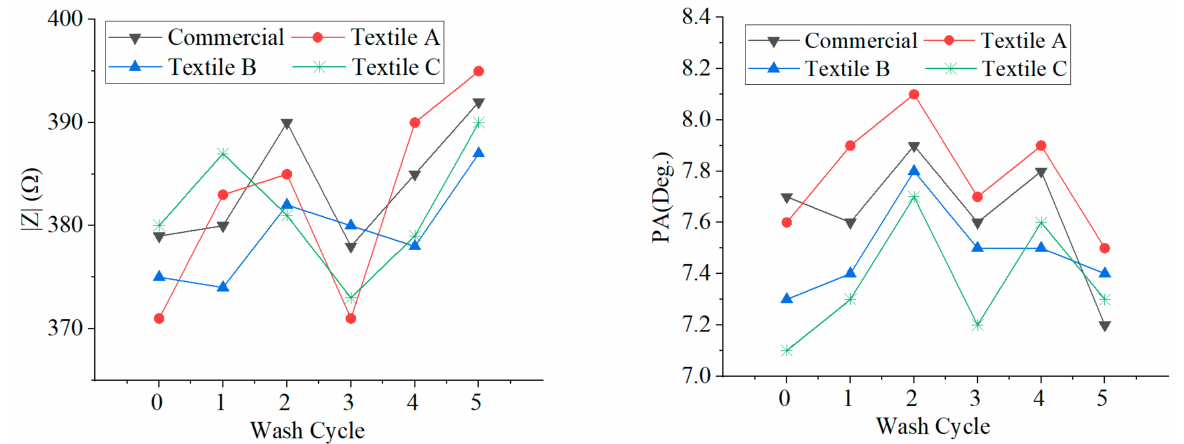
Figure 8. Investigation of the performance of the textile electrodes after washing.